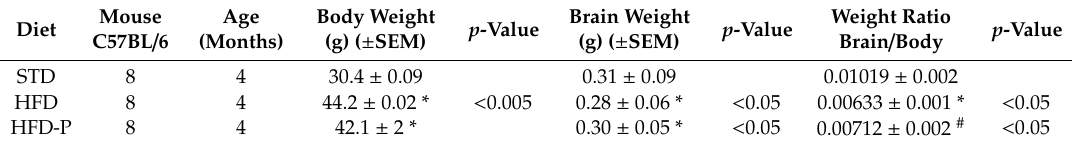
Table 1. E ff ects of pistachio diet on body weight and brain weight. HFD-P showed significantly increased brain / body weight ratio in comparison with HFD, suggesting a preventive action of pistachio consumption against brain atrophy.